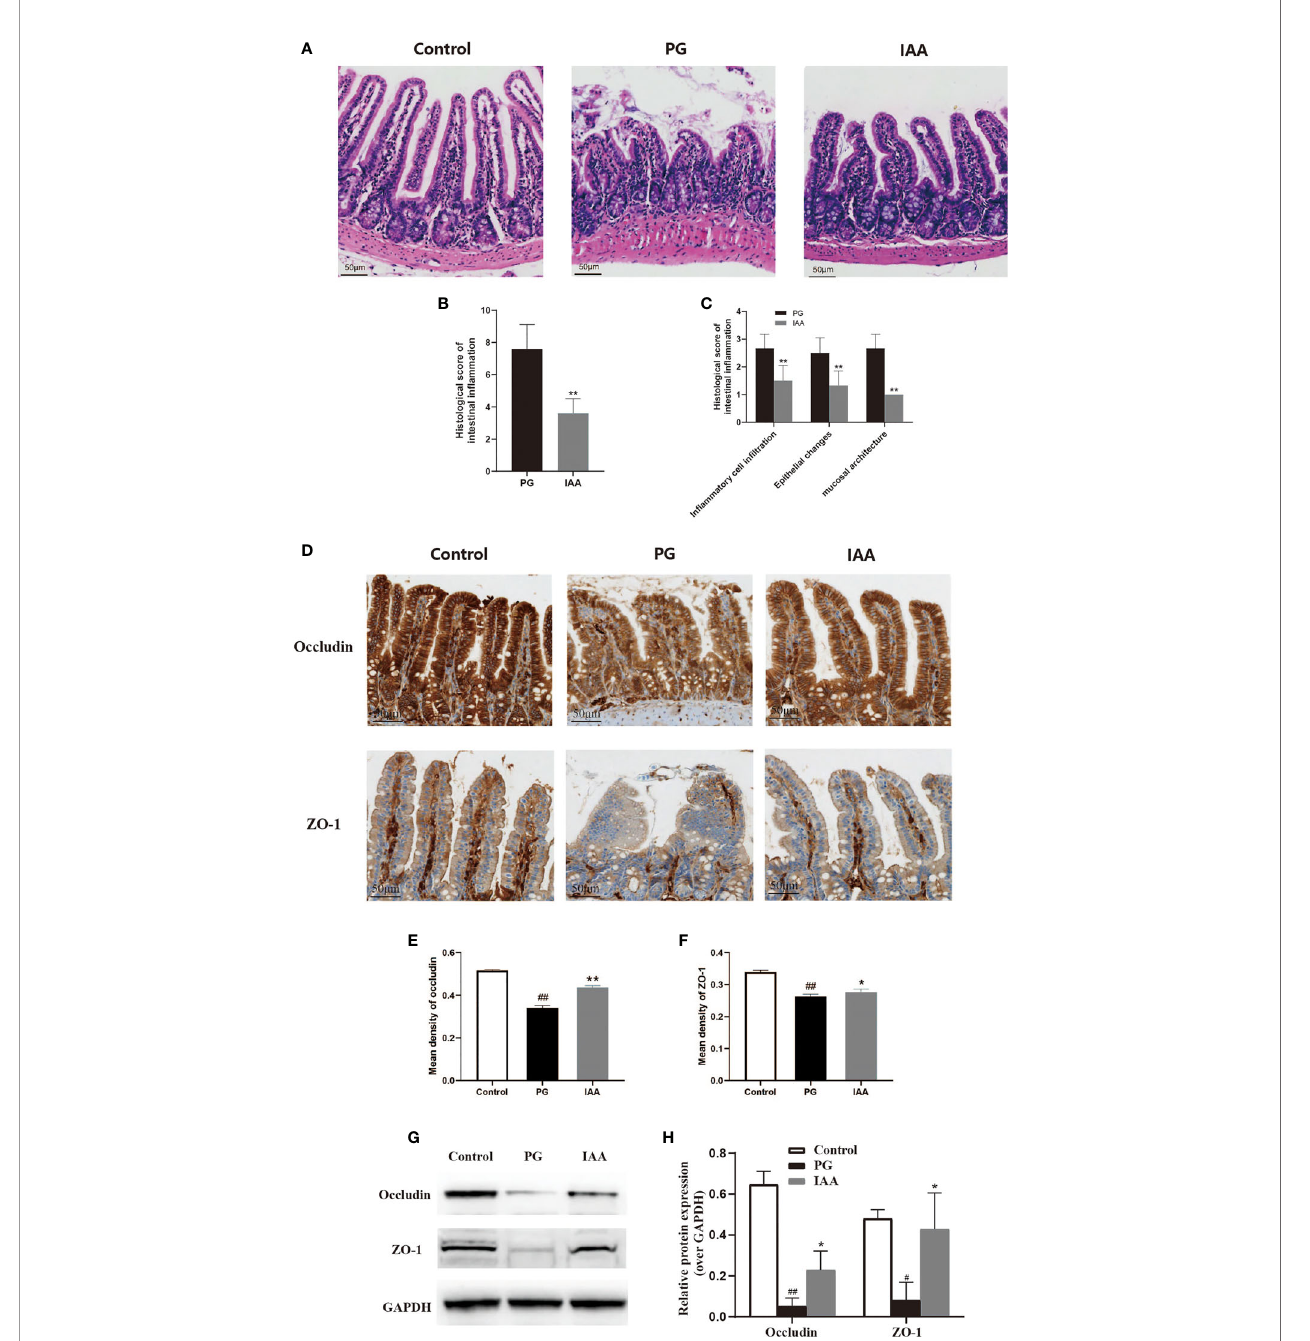
FIGURE 3 | IAA ameliorates the pathological morphology of ileum tissue and improves intestinal mucosal barrier function in AS mice. (A) Representative pictures of ileum sections from three groups of mice at the end of week 14. (HE staining, scale bar = 50 µm). (B) Histologic scores for intestinal in fl ammation in the proteoglycan (PG) and indole-3 acetic acid (IAA) group (n = 6). (C) Histologic score of intestinal in fl ammation was divided into three categories: in fl ammatory cell in fi ltrates, epithelial changes, and mucosal architecture (n = 6). (D) The proteins of ZO-1 and occludin in ileum tissue from three groups of mice were detected by immunohistochemistry, as shown in representative pictures from one of three independent experiments (scale bar = 50 µm). (E) ZO-1 and (F) occludin staining intensities were quanti fi ed as the mean optical density (n = 6). (G) The tight junction protein (ZO-1 and occludin) levels in ileum tissue from three groups of mice were analyzed by western blot analysis, as shown in representative blots from one of three independent experiments. (H) Relative protein expression of ZO-1 and occludin using densitometric analysis, with GAPDH as a loading control (n = 3). Data are expressed as the mean ± standard deviation (SD); # p < 0.05, ## p < 0.01 vs. control; * p < 0.05, ** p < 0.01 vs. PG alone. HE, hematoxylin and eosin; ZO-1, zonula occludens-1; GAPDH, glyceraldehyde 3-phosphate